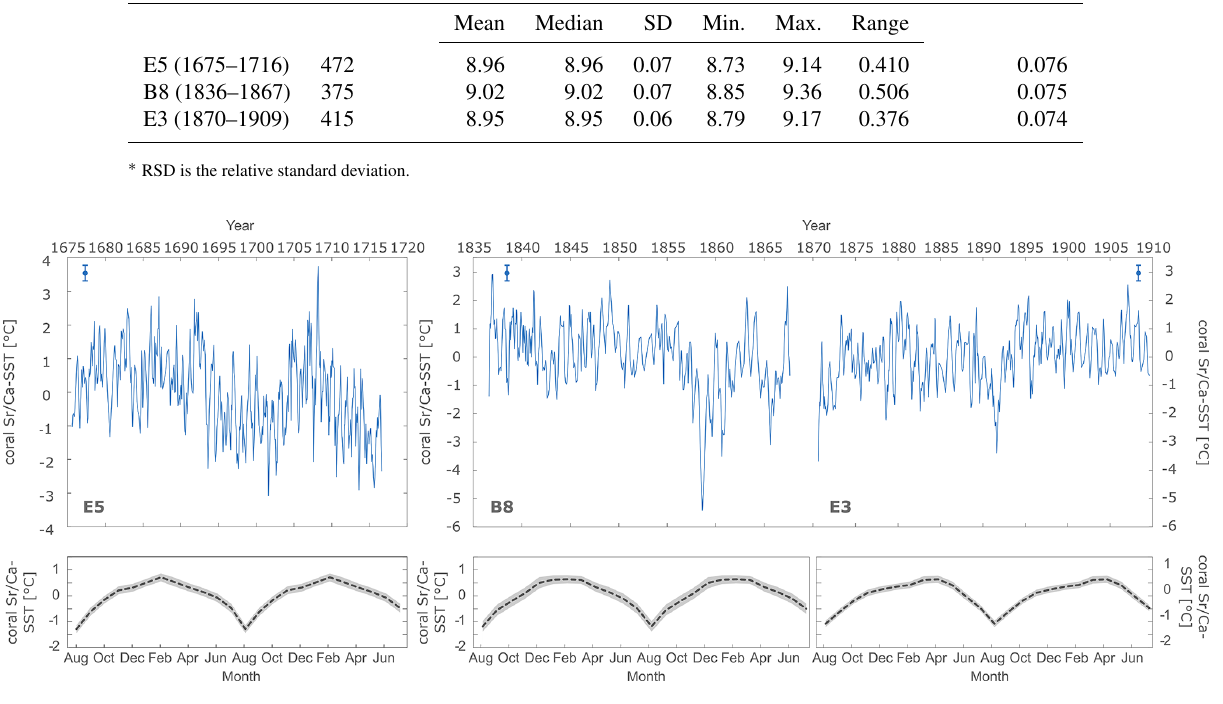
Figure 4. Monthly Sr / Ca records (blue lines; converted into coral Sr / Ca–SST in ◦ C) of E5 (1675–1716), B8 (1836–1867), and E3 (1870– 1909) with error bars indicating the standard deviation ( ± 2 σ ) of Sr / Ca ratios from multiple measurements on the same day and on consec- utive days and mean annual cycles (black lines and corresponding standard errors highlighted in gray, lower